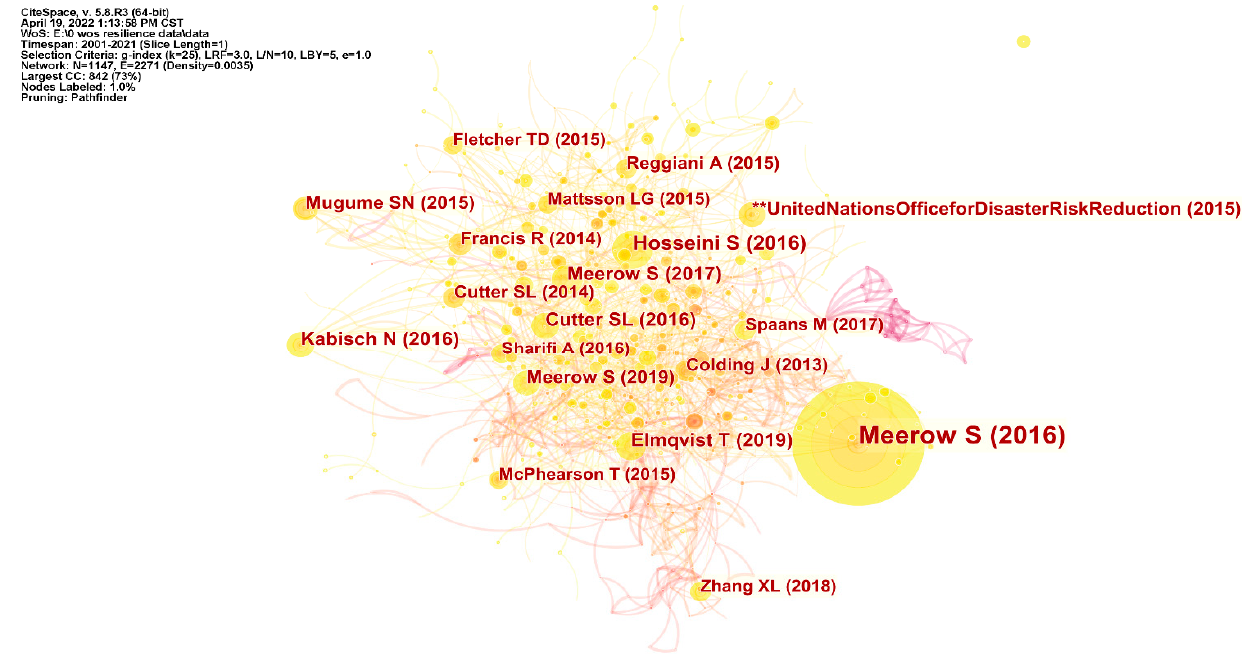
Figure 5. Collaborative co-occurrence map of highly cited articles in RC research. Table 3. Highly cited references of RC American scholar S. Meerow (the most significant nodes in the figure represent the high- est citation rates). Meerow attempts to view the resilience of a collection of target capabil-